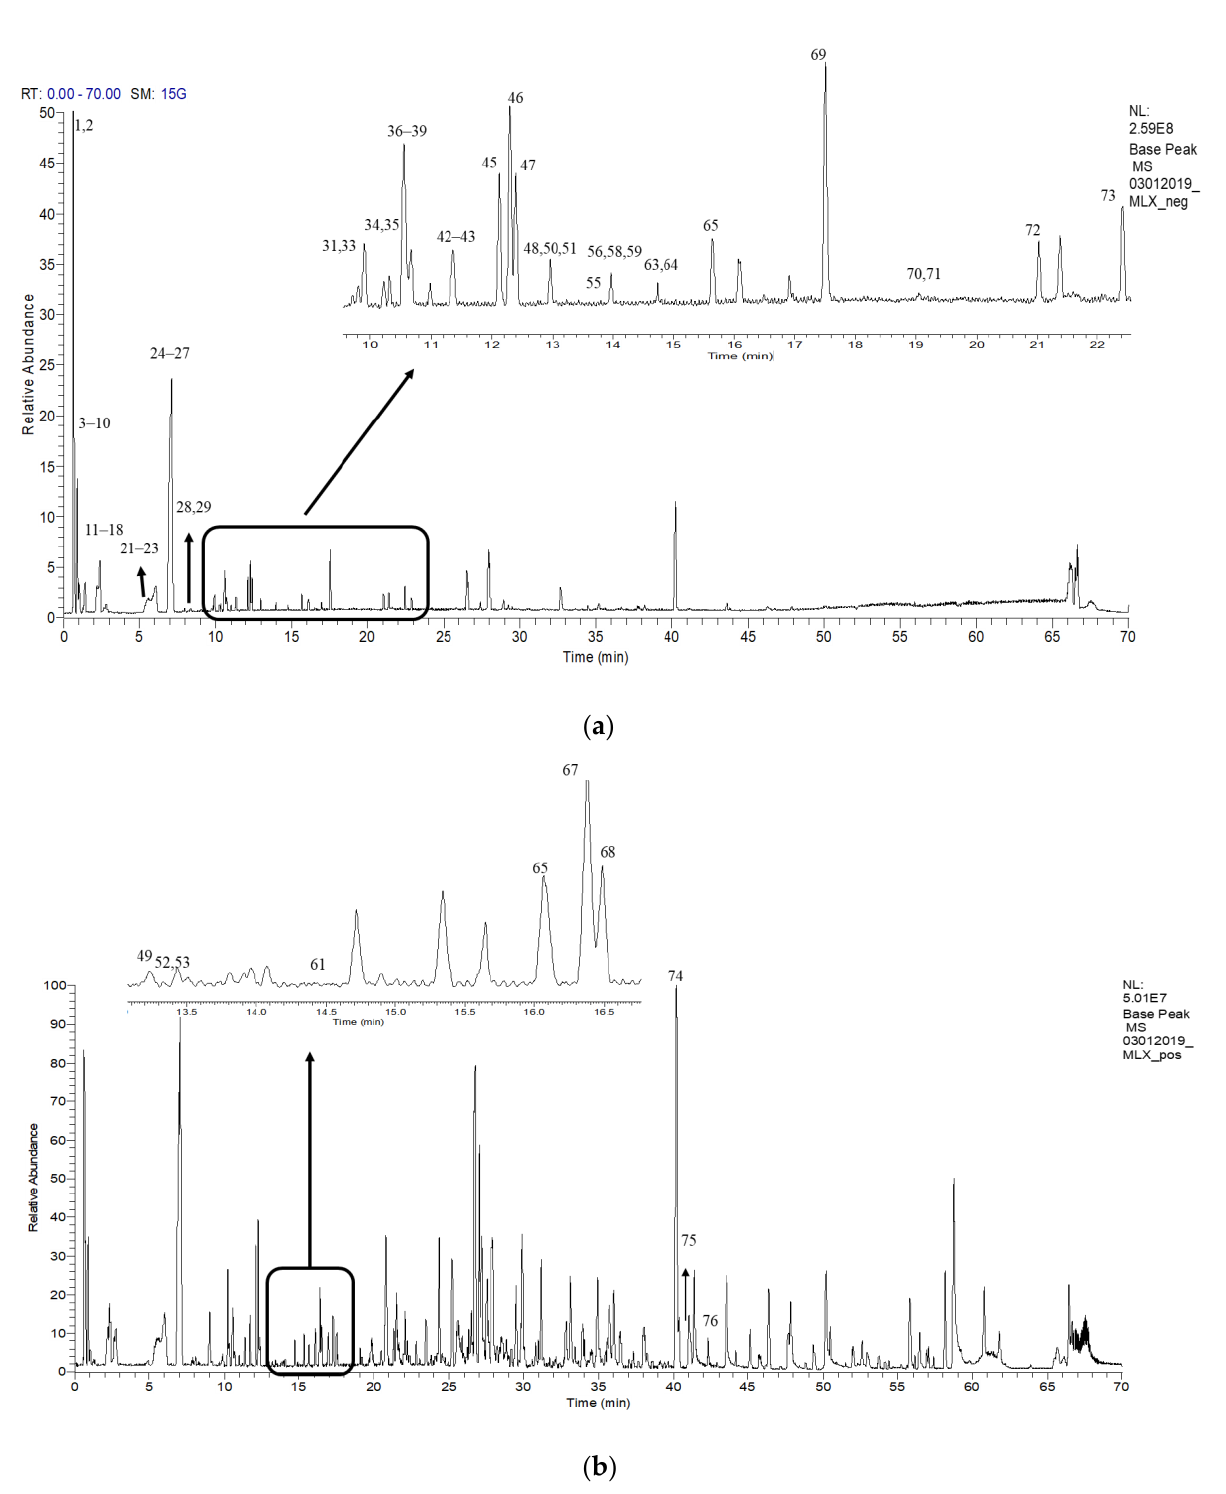
Figure 1. LCMS base peak chromatogram of A. pavarii leaf methanol extract in negative ( a ) and positive ( b ) ionization modes.